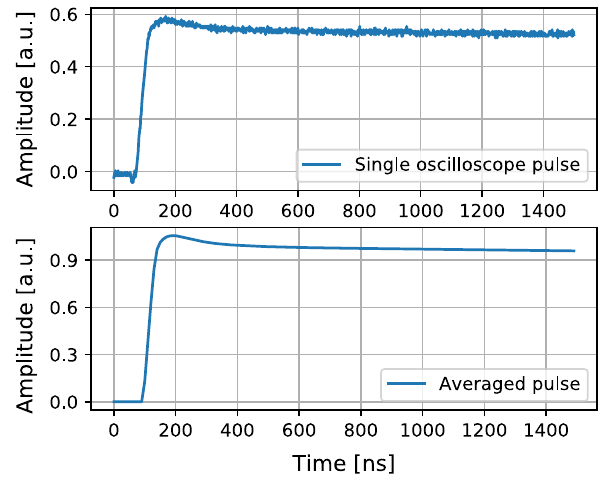
Fig. 14 Impulse response of the preamplifier. The top panel shows a singlewaveformcapturedbytheoscilloscope.Itwasinducedwithafast (rise time < 5ns) square pulse fed into the test input of the preamplifier. The bottom panel shows the response with the noise removed: for each single waveform ten consecutive points were averaged together and then 1000 of such waveforms were added and normalized (after the horizontal alignment)